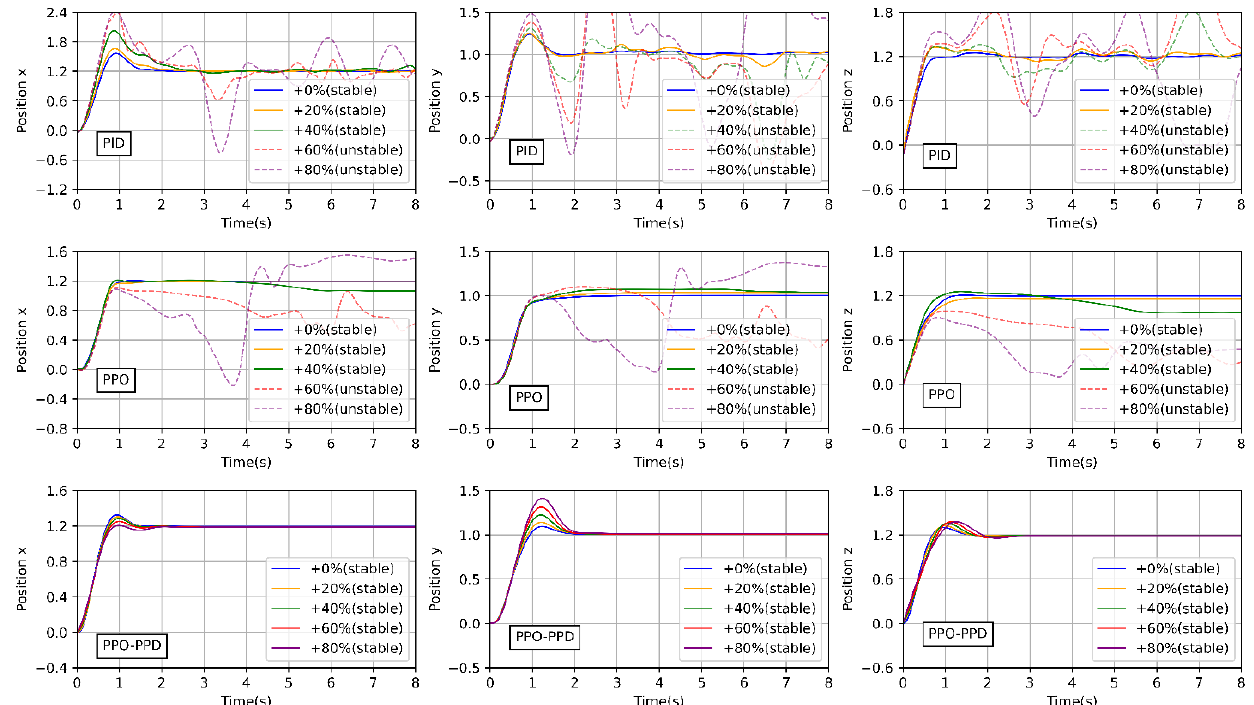
Figure 15. Position comparison among PID, PPO and PPO-PPD controller with different payloads.